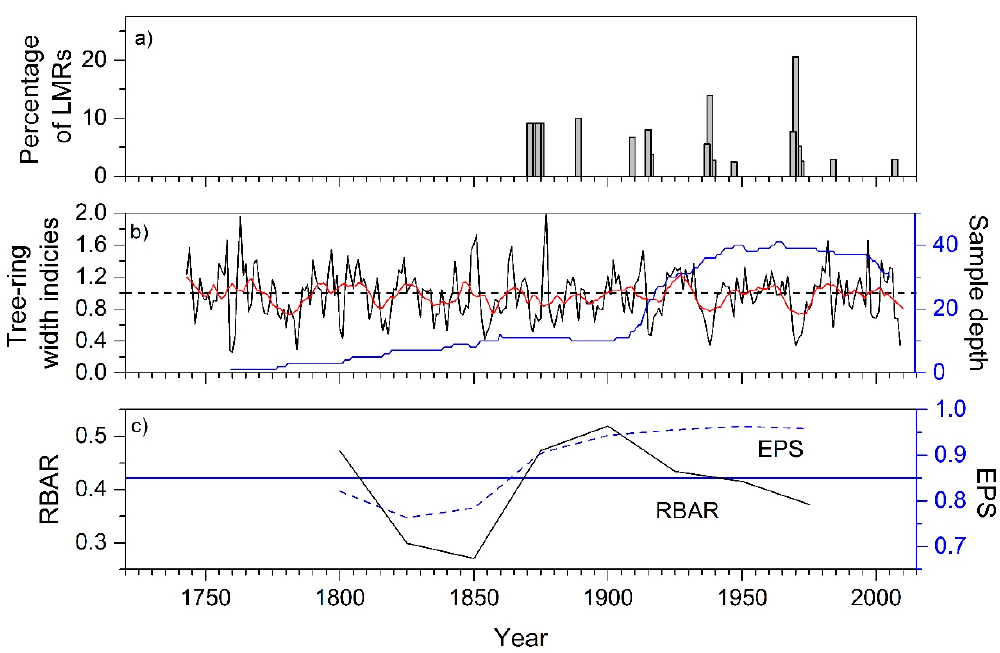
Figure 4. ( a ) Percentage of locally missing rings (LMRs) over the well-replicated period (1875–2010); ( b ) Tree-ring width chronology of Chir pine from Kailali, western Nepal Himalayas, with the 10-year moving average curve (solid red line), sample depth (the blue line shows the number of sampled trees or sample depth); ( c ) variation of mean series inter-correlation (RBAR) and Expressed Population Signal (EPS, dashed blue line) over time (the horizontal blue line represents the EPS threshold (i.e., 0.85) often used to demonstrate well-replicated chronologies). RBAR and EPS were calculated using 50-year moving windows with a 25-year overlap. Table 1. Characteristics of the Pinus roxburghii ring-width chronology for a common interval, i.e., the best-replicated period (1900–2010).